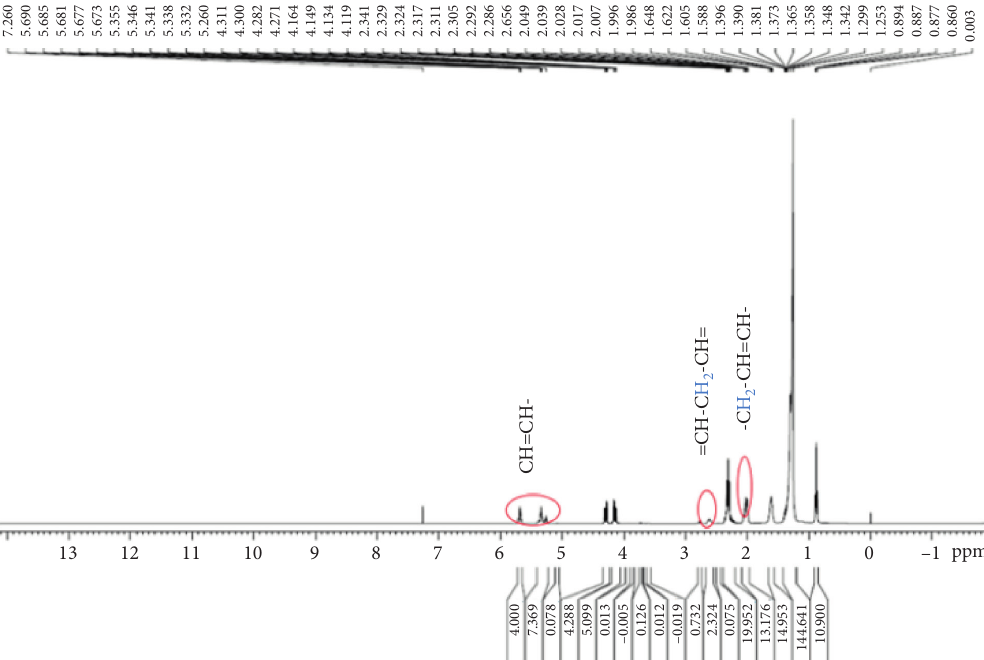
Figure 20: 1 H NMR spectra of chaulmoogra oil showing chemical shift corresponding to olefinic, bis-allylic, and allylic